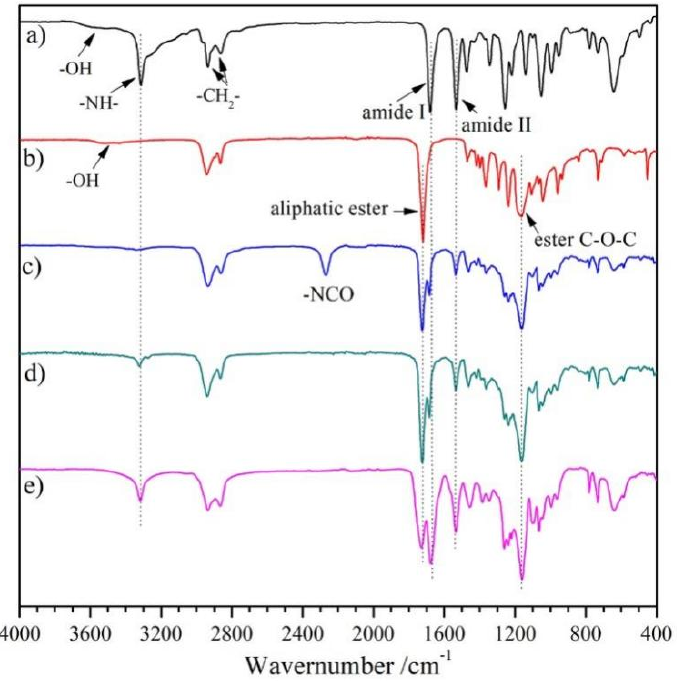
Figure 3. FT ‐ IR spectra for ( a ) BHB, ( b ) PCL, ( c ) OCN ‐ PCL ‐ NCO, ( d ) PEU ‐ 1.0 and ( e ) PEU ‐ 2.0.